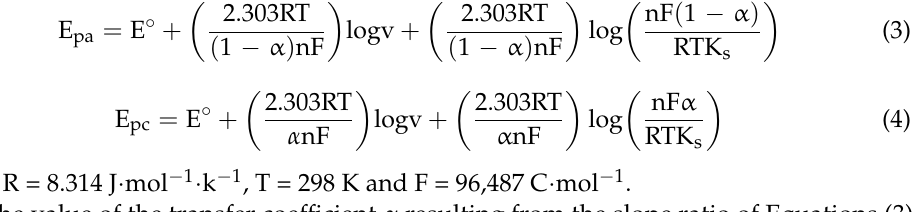
SN Scheme 1. Toluidine blue electro-oxidation